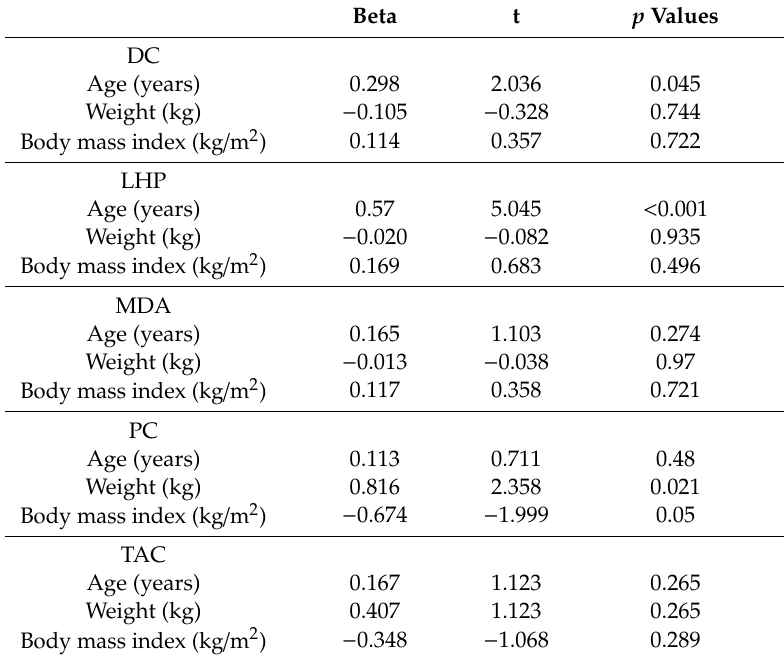
Table2. Linearregressionmodeladjustedforage, weight, andbodymassindex(BMI)inoxidativestress.